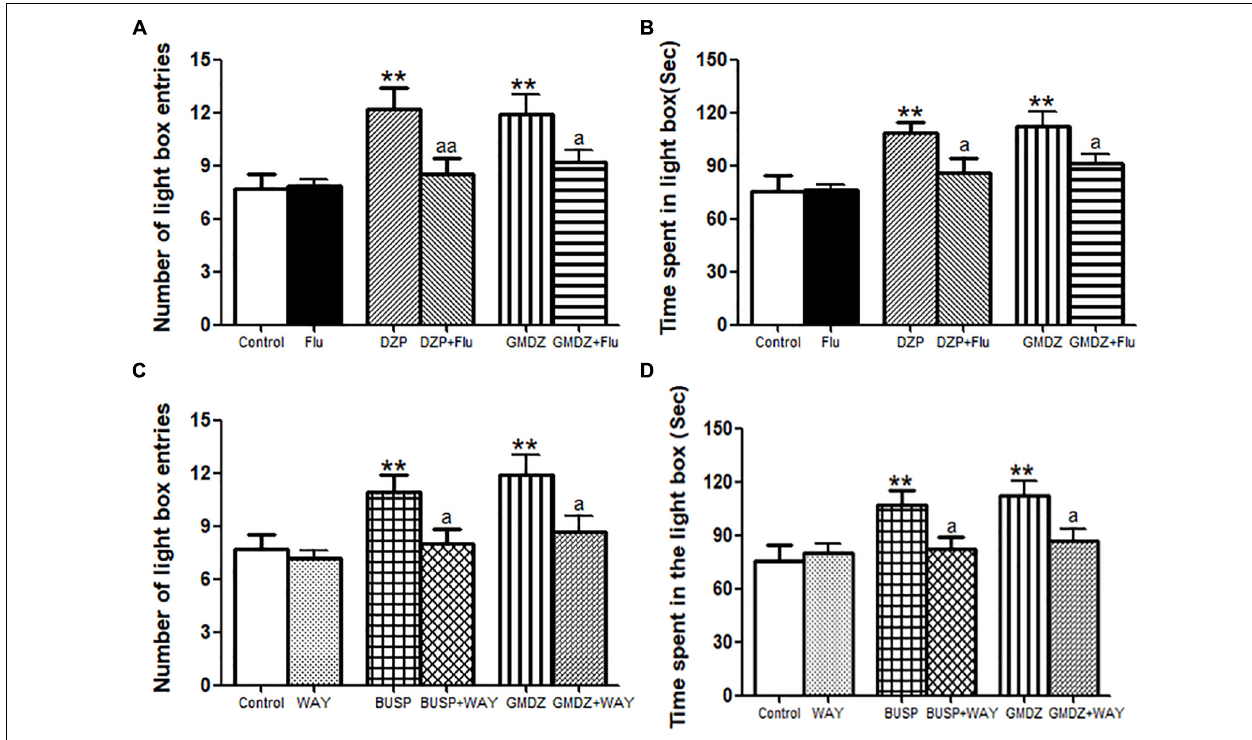
FIGURE 6 | Effect of receptor antagonists on the anxiolytic-like effect of GMDZ in the LDB test. (A) Effect of Flu on the numbers of light box entries. (B) Effect of Flu on the time spent in the light box. (C) Effect of WAY on the numbers of light box entries. (D) Effect of WAY on the time spent in the light box. Value are represented as mean ± SEM ( n = 12). ∗∗ P < 0.01 vs. control group; a P < 0.05 or aa P < 0.01 treatment vs. antagonist (interaction effect). Two-way ANOVA with Bonferroni post hoc